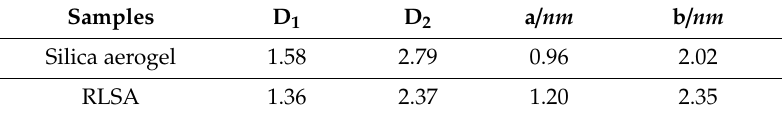
Table 1. Fitting results of SAXS data.